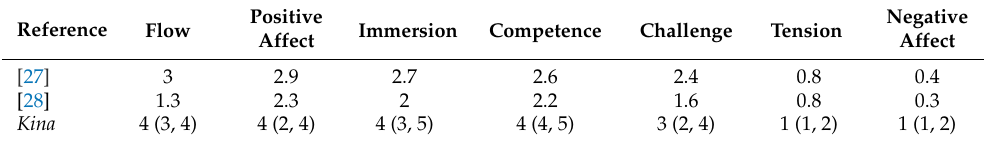
Table 11. Kina ’s GEQ score compared to other studies.